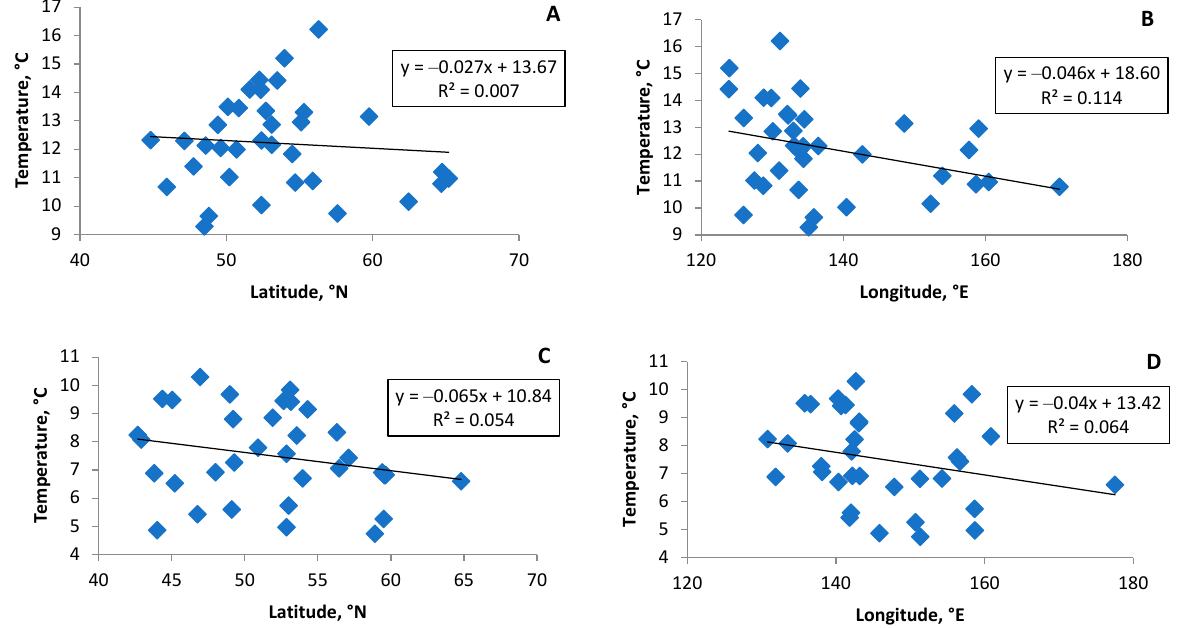
Figure 2. Scatterplots of diurnal temperature range (DTR) vs. latitude ( A , C ) and longitude ( B , D ) for locations in the Russian Far East for the period 2000–2019; ( A , B ) continental weather stations, ( C , D ) maritime weather stations. Black solid line is plotted as the least-square linear regression.